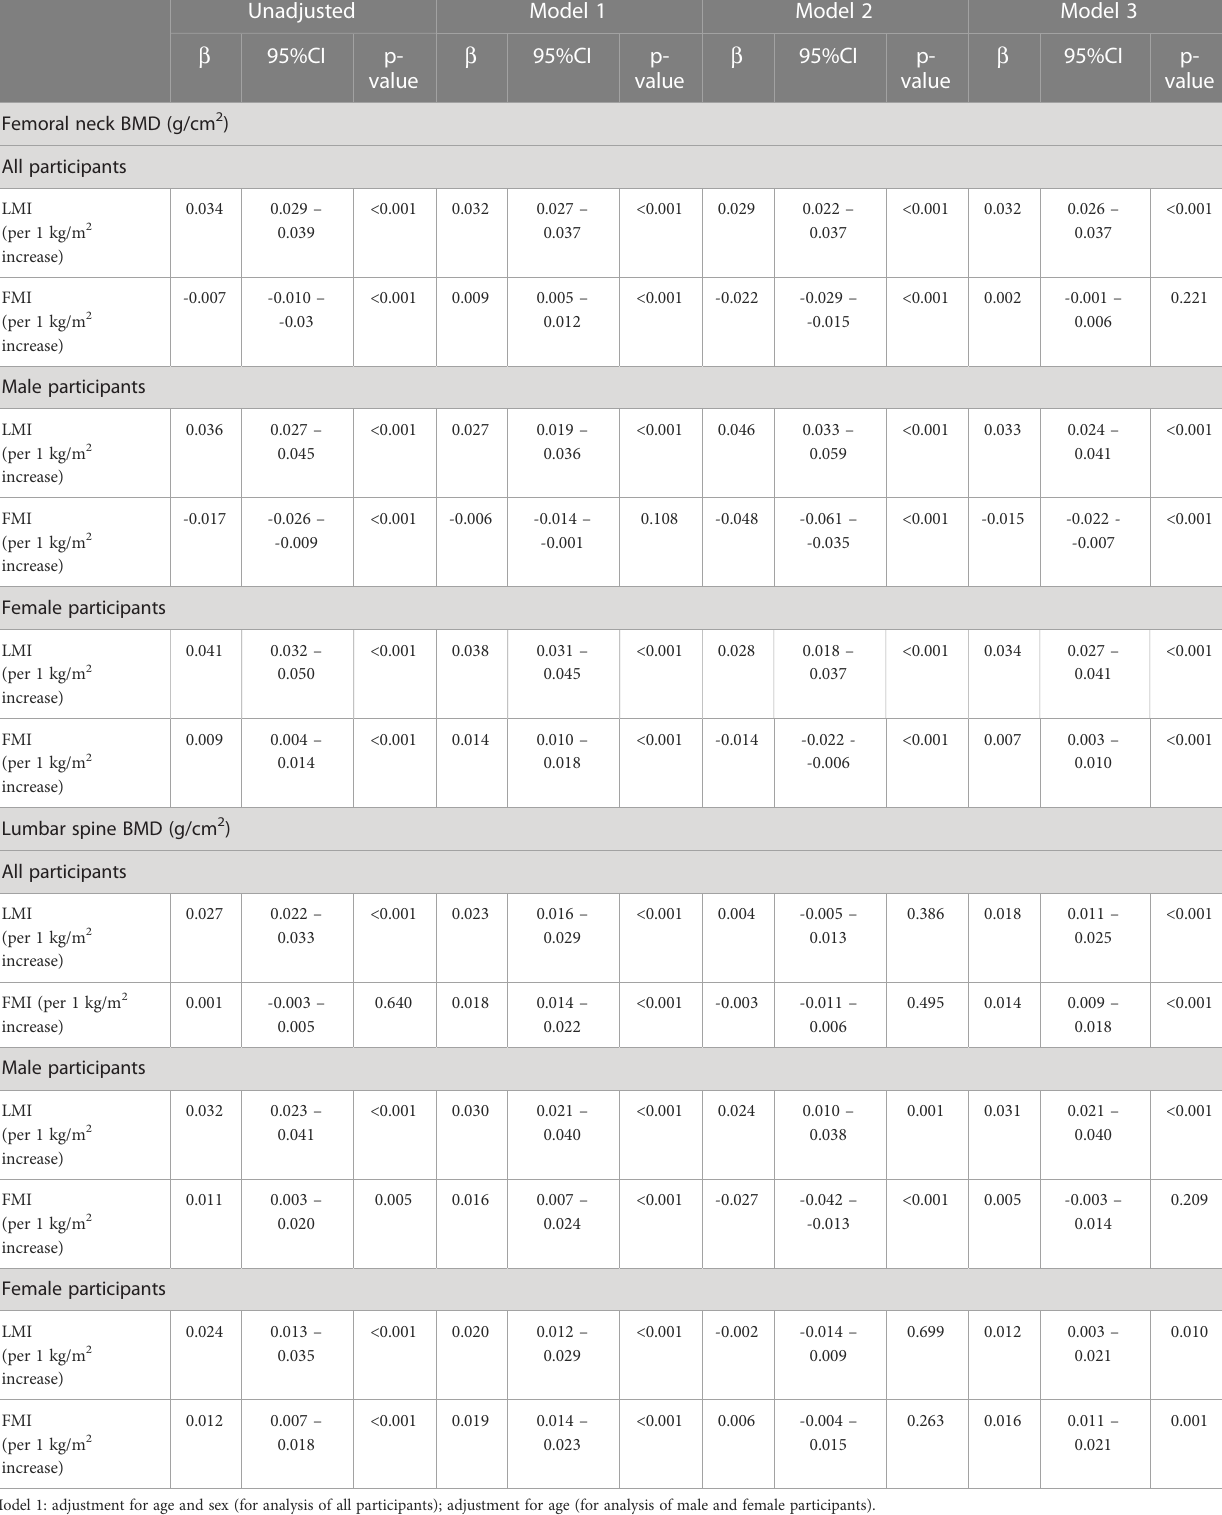
Model 1: adjustment for age and sex (for analysis of all participants); adjustment for age (for analysis of male and female participants). Model 2: adjustment for age, sex, height and BMI (for analysis of all participants); adjustment for age, height and BMI (for analysis of male and female participants). Model 3: adjustment for age, sex and height with LMI and FMI included in the same model (for analysis of all participants); adjustment with age and height, with LMI and FMI included in the same model (for analysis of male and female participants). BMI was removed from the model due to multicollinearity. BMD, Bone mineral density; BMI, Body mass index; FMI, Fat mass index; LMI, Lean mass